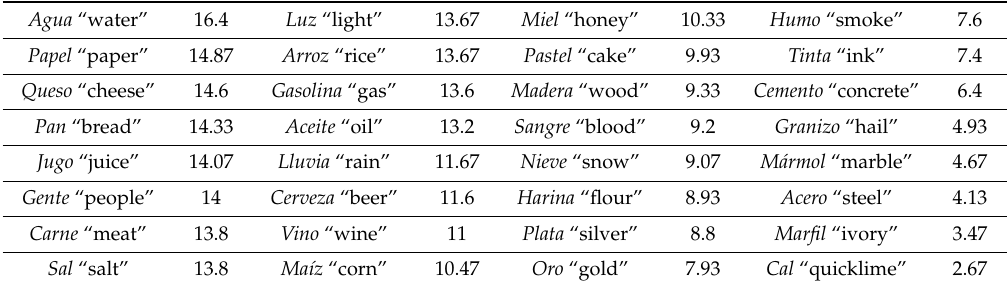
Table A1. Lexical frequency count of the lexical items under examination as determined by the heritage speakers’ responses to the self-reported lexical frequency task.